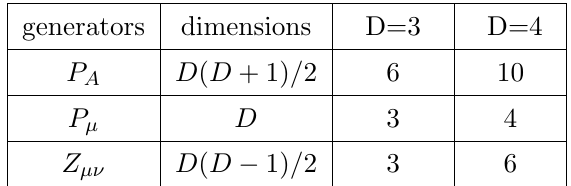
Table 1 . Translation generators.